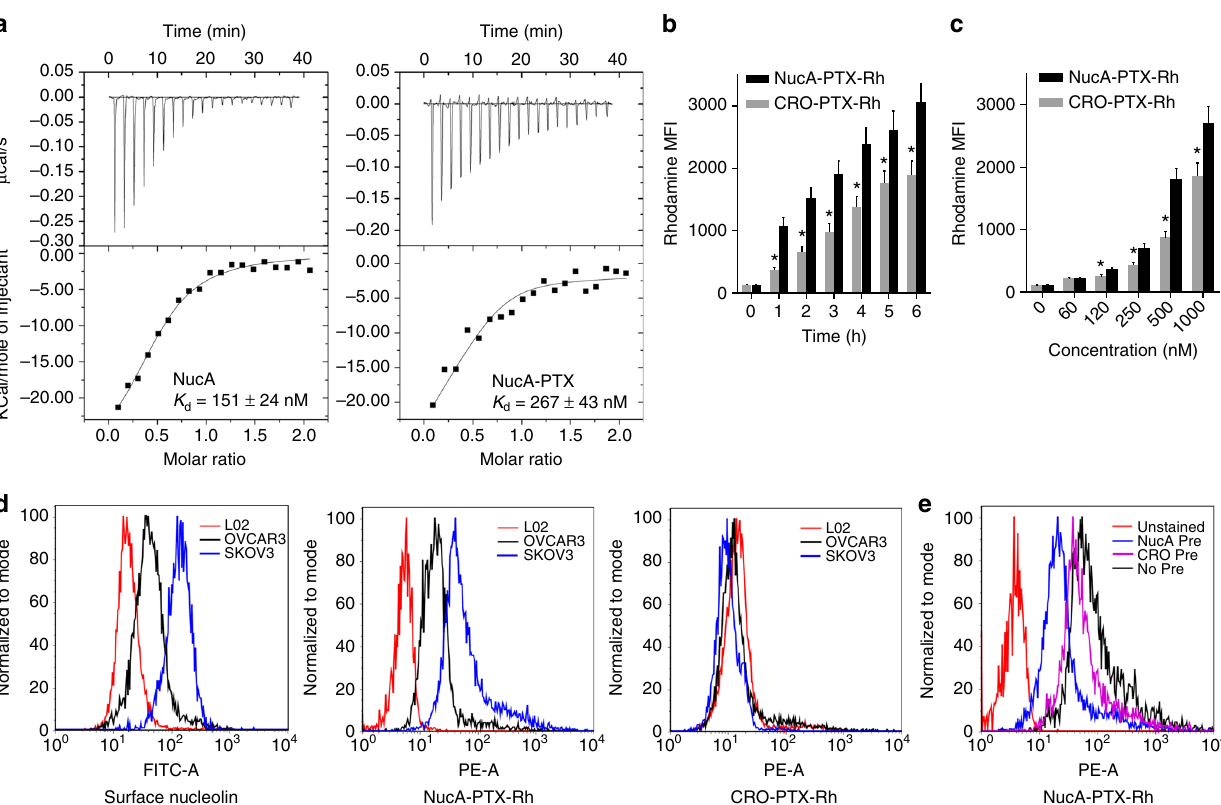
Fig. 3 The effect of NucA modi fi cation on the uptake of the conjugated PTX-Rh. a The interaction of nucleolin with NucA and NucA-PTX, respectively, detected by isothermal titration calorimetry (ITC). NucA or NucA-PTX was injected into nucleolin at a 10:1 ratio in 19 portions (each portion 2 μ L) at 25 °C. b The time-dependent cellular uptake of the conjugated PTX-Rh in SKOV3 cells examined by fl ow cytometry. SKOV3 cells were incubated with either NucA-PTX-Rh or CRO-PTX-Rh at a concentration of 500 nM for 1 to 6 h. Error bars indicate mean ± standard deviation. n = 5, * P < 0.05. c The concentration-dependent cellular uptake of the conjugated PTX-Rh in SKOV3 cells examined by fl ow cytometry. SKOV3 cells were incubated with either NucA-PTX-Rh or CRO-PTX-Rh at a range of concentrations for 2 h. Error bars indicate mean ± standard deviation. n = 5, * P < 0.05. d The nucleolin expression on cell surface, and the uptake of NucA-PTX-Rh or CRO-PTX-Rh in SKOV3, OVCAR3 and L02 evaluated by fl ow cytometry. The cells were treated with NucA-PTX-Rh or CRO-PTX-Rh at a concentration of 100 nM for 2 h. The nucleolin expression was detected using Alexa488-labeled anti- nucleolin antibody shown in the FITC channel, and the rhodamine level of the conjugates was shown in the PE channel. e The cellular uptake of NucA-PTX- Rh in SKOV3 pre-incubated with either NucA (NucA Pre) or CRO (CRO Pre) analyzed by fl ow cytometry. The cells were pretreated with 250 nM NucA or CRO for 2 h before incubated with 100 nM NucA-PTX-Rh for 2 h. The rhodamine level of NucA-PTX-Rh was shown in the PE FAM-NucA-PTX-Rh was designed according to the fl uorescence resonance energy transfer (FRET) principle (Fig. 2a). Fluorescein amidate (FAM) was linked to the 5 ′ end of NucA as the donor and rhodamine B (Rh) was linked to the 7-hydroxyl group of PTX as the acceptor. When the dipeptide linker stays intact, the fl uorescence of both fl uorophores in FAM-NucA-PTX-Rh remained stable. Whereas when the linker is hydrolyzed in the presence of the speci fi c protease — cathepsin B, FRET between FAM and rhodamine B is interrupted, appeared as the decrease of Rh intensity and the increase of FAM intensity. With an excita- tion wavelength at 470 nm, FRET was noted in the fl uorescence emission spectrum of FAM-NucA-PTX-Rh compared to the individual spectra of FAM-NucA and PTX-Rh (Fig. 2b). Whereas, in the presence of cathepsin B, increased emission at 520 nm and decreased emission at 590 nm upon time were observed in the spectra of FAM-NucA-PTX-Rh (Fig. 2c). Accordingly, the con- centration of intact FAM-NucA-PTX-Rh could be presented by